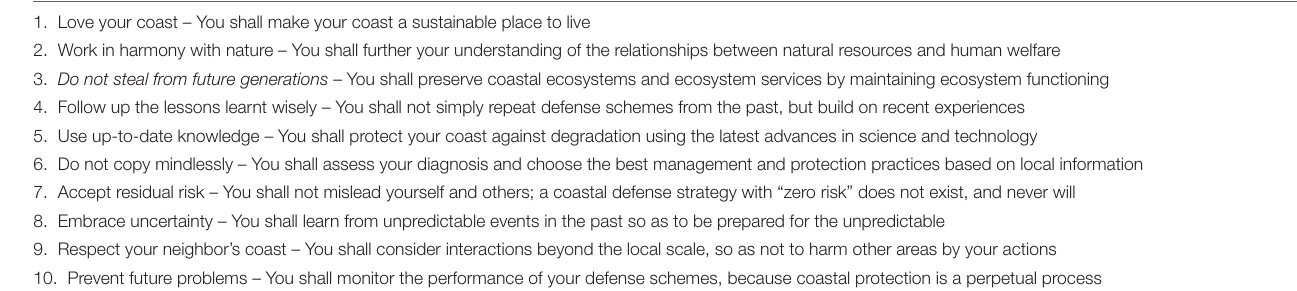
TABLE 2 | Ten commandments for sustainable, safe, and W/Healthy sandy coasts facing global